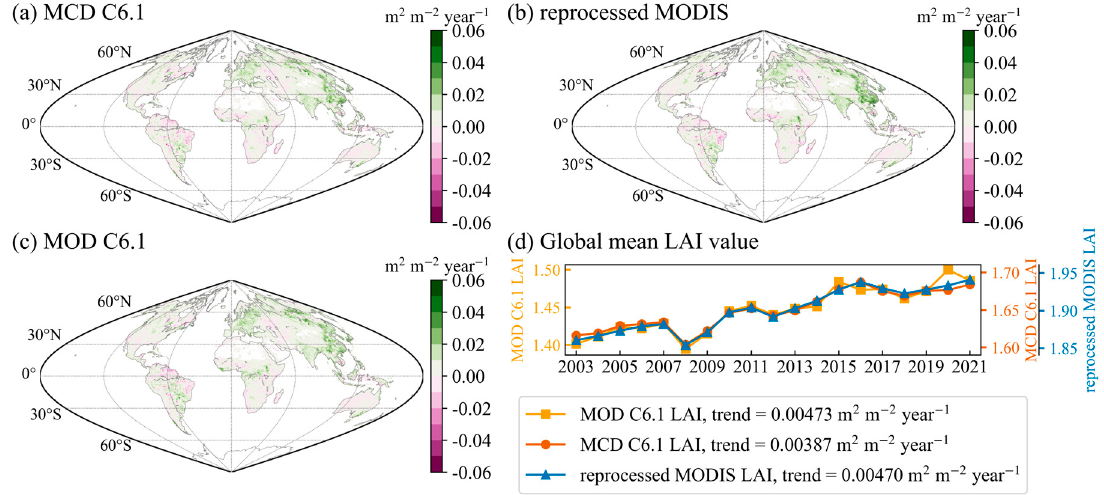
Figure 8. Linear trends of the growing season mean LAIs of ( a ) MCD15A2H C6.1, ( b ) reprocessed MODIS, ( c ) MOD15A2H C6.1, and ( d ) their global mean values in 2003–2021. Trends of LAI mean values of all products in ( d ) are significant ( p < 0.05 in the Mann–Kendall